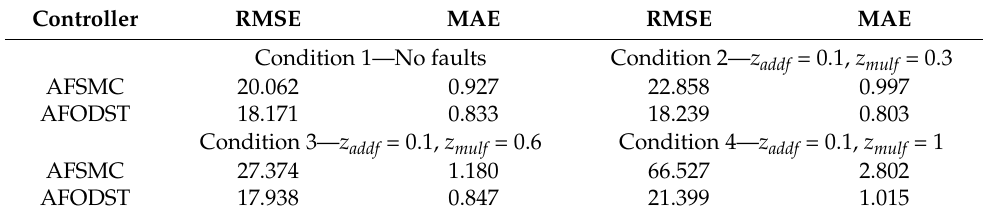
Table 2. Tension Control Performance